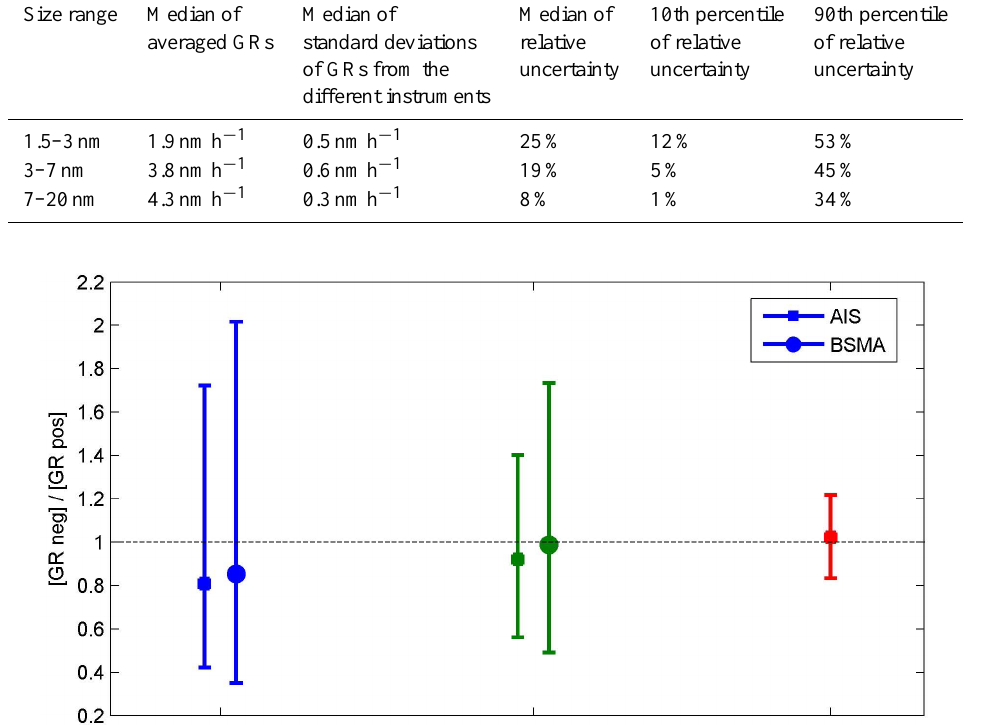
Fig. 5. Ratios of particle growth rates estimated from measurements of positively and negatively charged particles. Results from the AIS and BSMA data are shown separately. The squares and circles represent the median value of the ratio of the growth rates for the size ranges (the growth rate obtained from the size distribution of negative particles divided by the growth rate obtained from the size distribution of positive particles). The whiskers represent the 10th and 90th